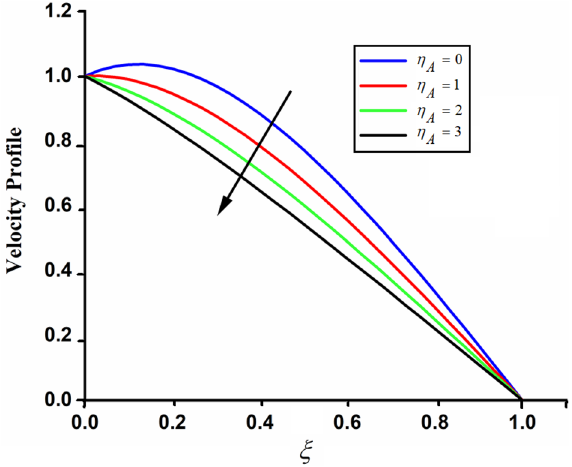
Figure 9. The impact of η A on fractal-fractional couple stress fluid velocity in channel when, α = 0.5 , β = 0.5 , Gr = 2 , Gm = 3 , M = 2 , K = 3 , P = 1.5 , Pr = 1.5 , Re = 2.5 and Sc = 0.3 .